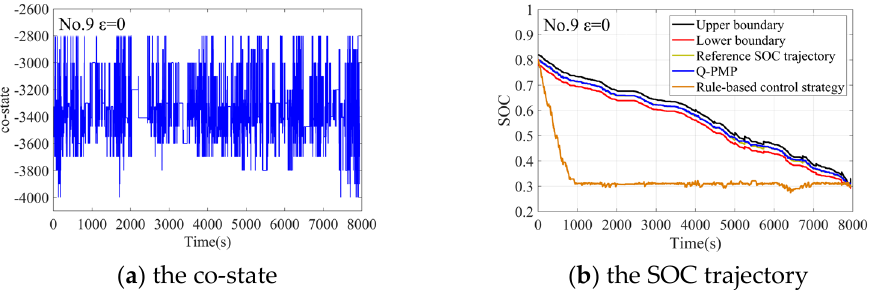
Figure 19. The HIL test results of combined driving cycle 9. Table 2. The fuel consumption of the HIL.